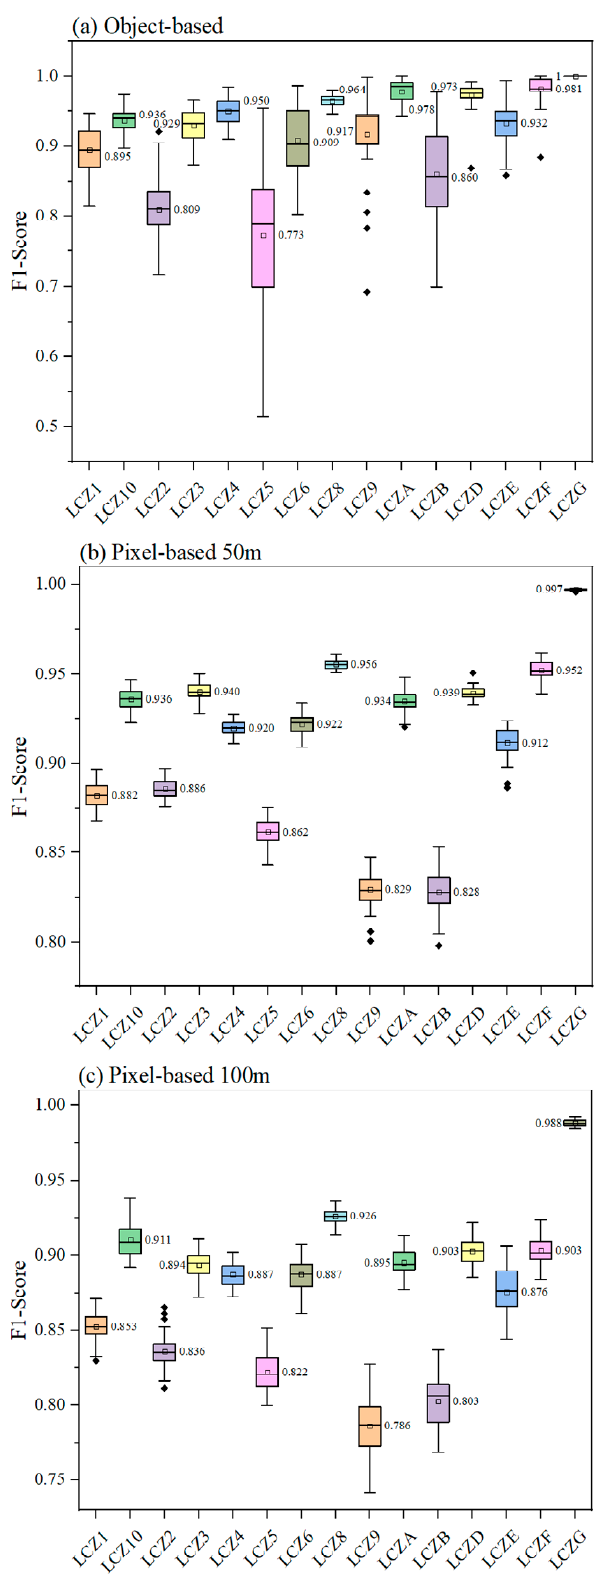
Figure 10. F1-score boxplots of the three classification schemes. ( a – c ) are the F1-scores of object- based, pixel-based in 50 m, pixel-based in 100 m respectively. The diamonds represent outliers. The horizontal line and the square in the box represent the median and mean of F1-scores for a set of data respectively. The number next to the box is the mean of